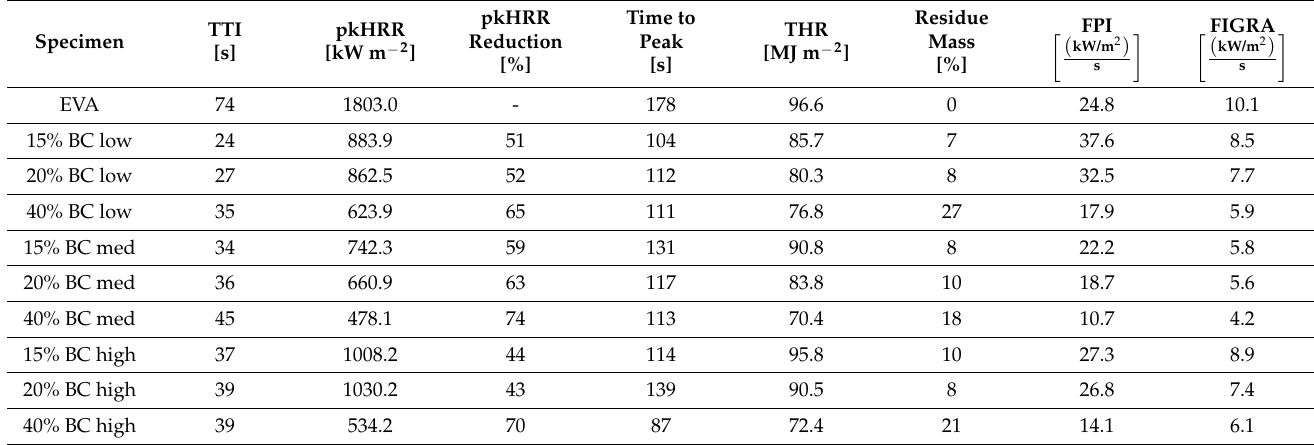
Table 3. Main thermal parameters by cone calorimetry tests.